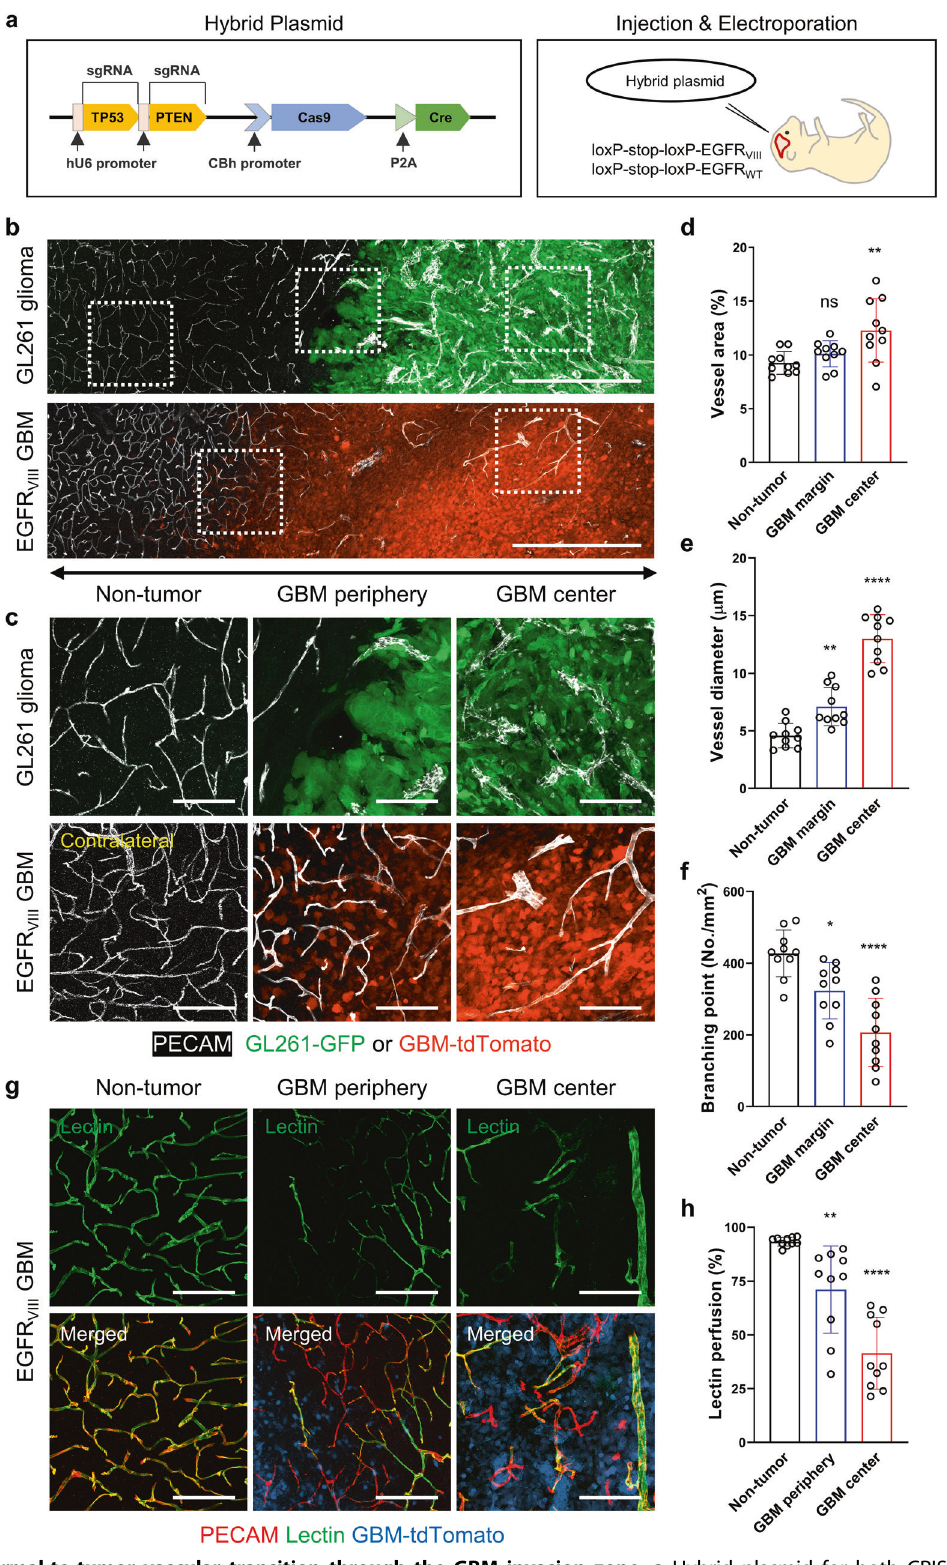
Fig. 1 Gradual normal-to-tumor vascular transition through the GBM invasion zone. a Hybrid plasmid for both CRISPR/Cas9-mediated gene inactivation and ectopic Cre expression (left). This plasmid was delivered into the brain cells of neonatal mice harboring the EGFR VIII gene cassette (right). b Panoramic images of vascular changes along the radial axis in GL261 glioma (upper) and EGFR VIII GBM (lower). c Magni fi ed images of the boxed area in ( b ). d – f Quanti fi cation of vascular morphology: ( d ) vessel area, ( e ) vessel diameter, and ( f ) vessel branching points. Note the increase in abnormalities toward the tumor center. g Images of lectin perfusion and h quanti fi cation of lectin-perfused vessels. Scale bars: 500 µm b , 100 µm c , g . ns not signi fi cant; *, P < 0.05; **, P < 0.01; ****, P < 0.0001 vs. nontumor